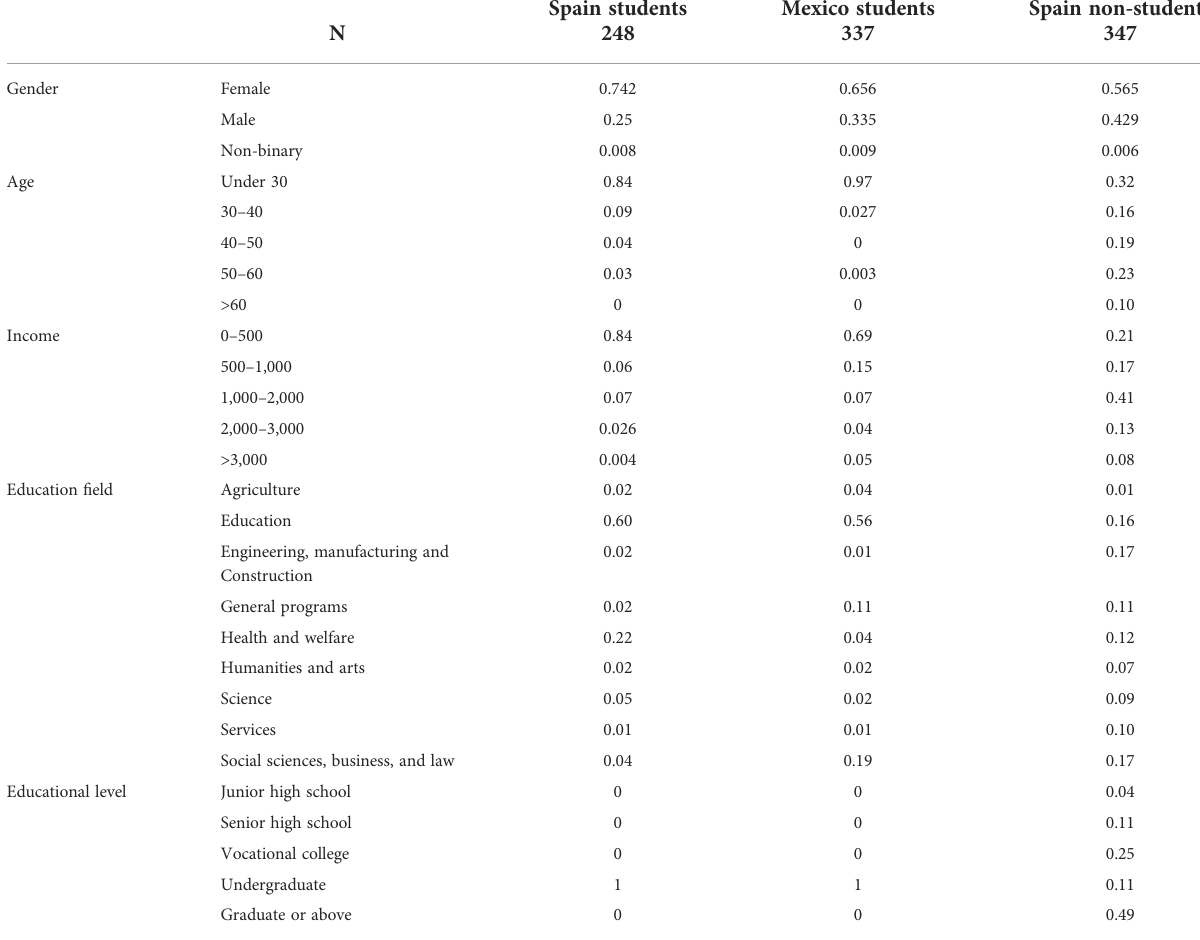
TABLE 2 Sociodemographic characteristics of the samples analyzed: students from Mexico and Spain and non-students from Spain. Spain